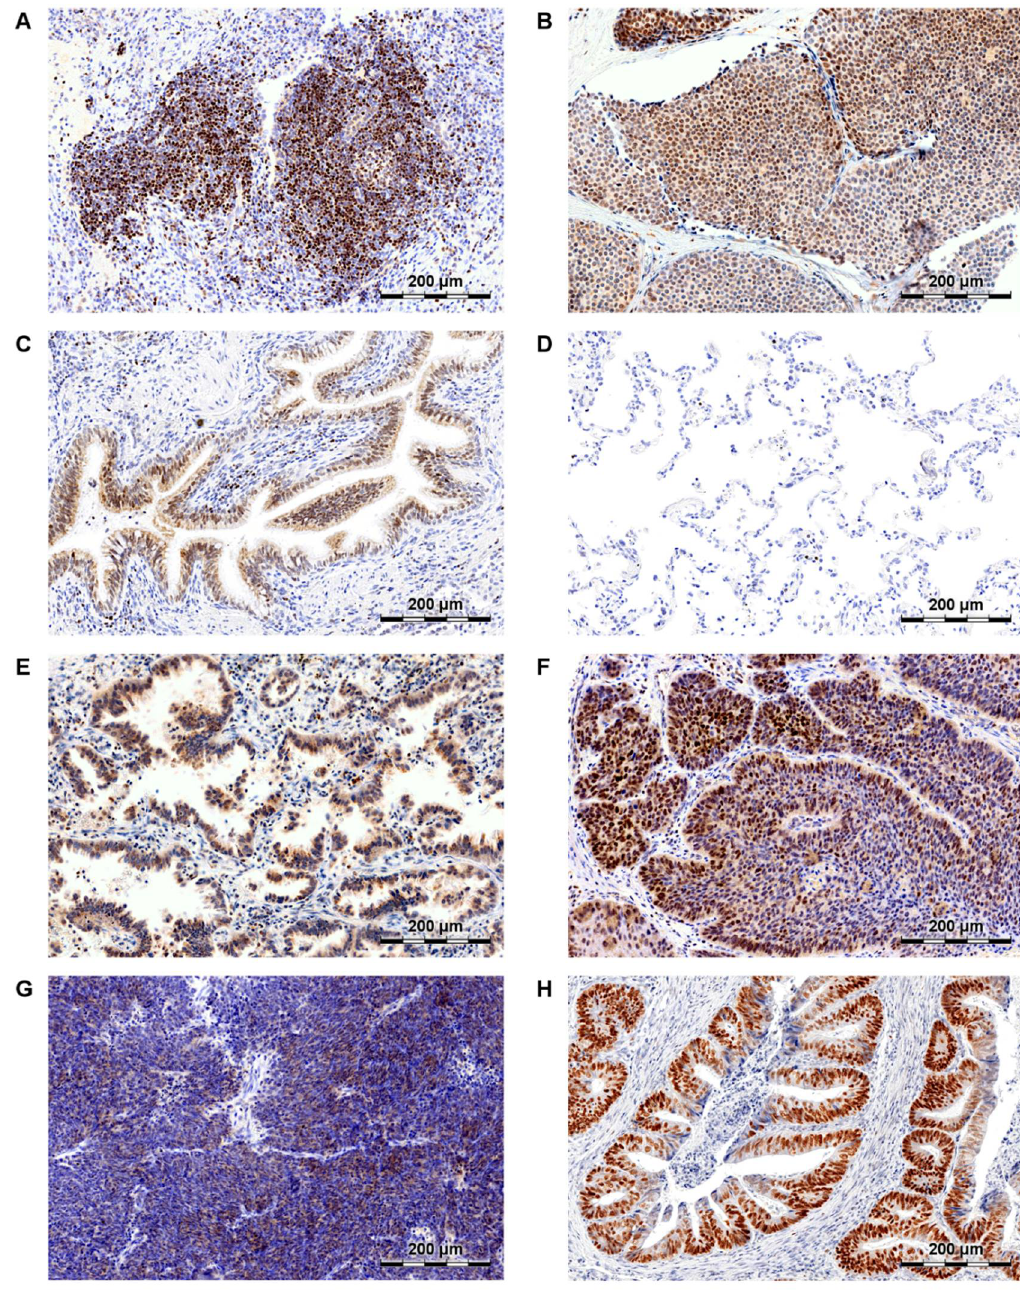
Figure 2. SATB1′s expression in human lymphocytes ( A ), breast cancer ( B ), normal airway epithelium ( C ), normal lung alveoli ( D ), lung adenocarcinoma (AC; E ), lung squamous cell carcinoma (SCC; F ), small cell lung carcinoma (SCLC; G ) and colorectal cancer (CRC; H ).